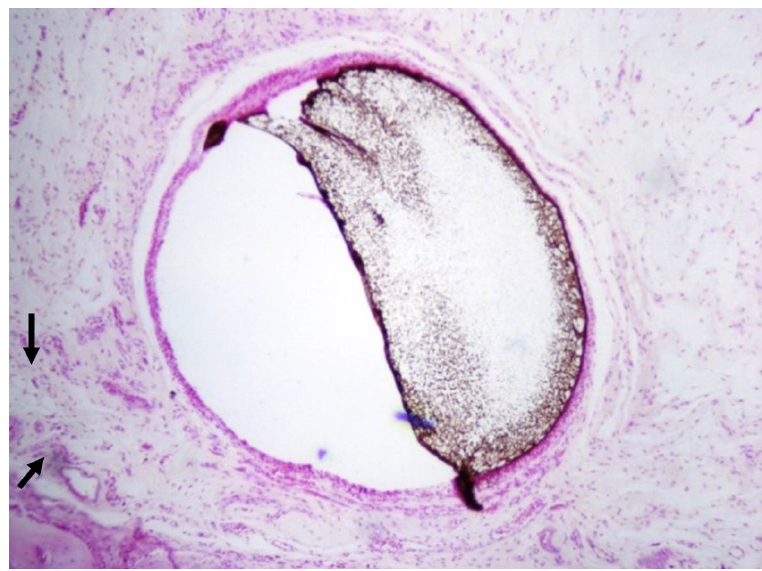
Figure 6. Magnified view showing mild inflammatory cell infiltrate composed primarily of lymphocytes and few scattered small blood vessels (arrows). H&E: hematoxylin & eosin stain, ×200.